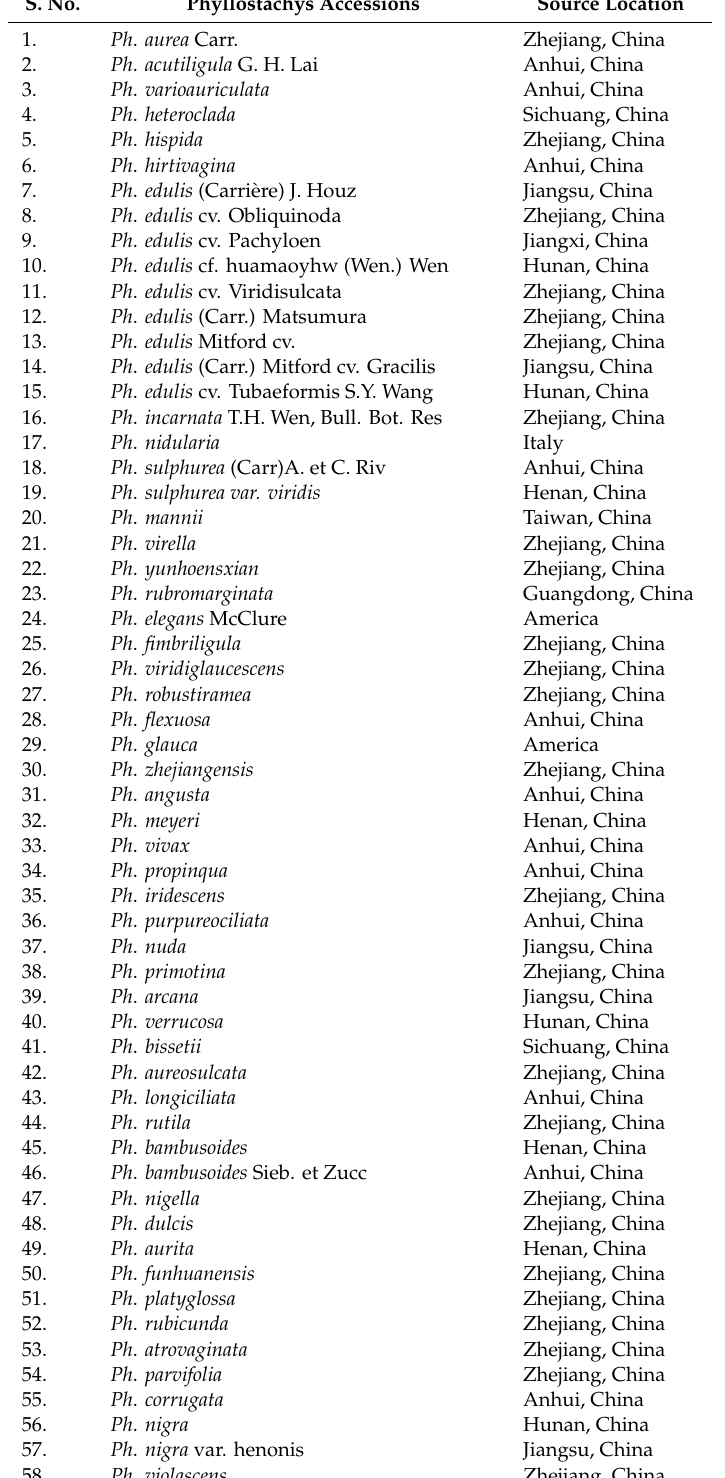
Table 1. List of 58 Phyllostachys accessions (Asian bamboo) collected from di ff erent geographical regions used for the analysis of genetic diversity using inter-retrotransposon amplified polymorphism (IRAP)